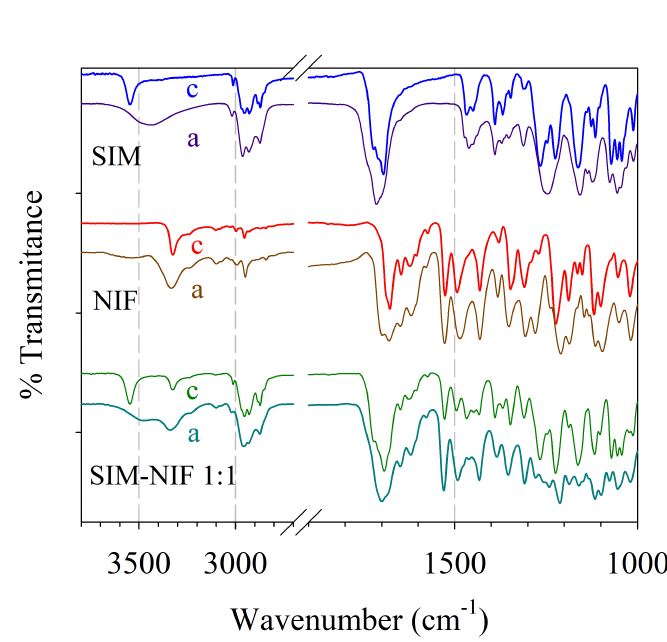
Figure 8. FTIR spectra of crystalline (c) and amorphous (a): SIM, NIF, and co-amorphous formulation SIM–NIF